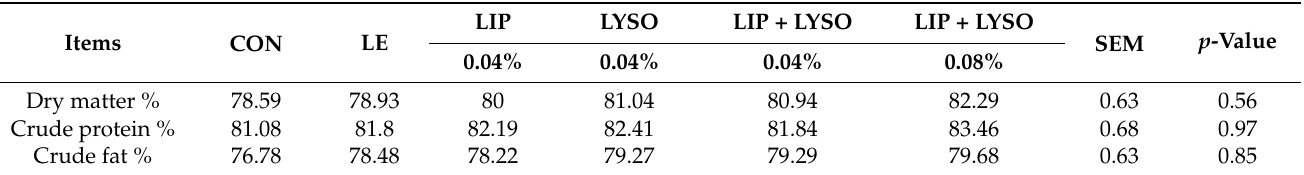
Table 3. Effect of low energy diet and supplementation of emulsifier and lipase on nutrient digestibil- ity in broiler chickens.